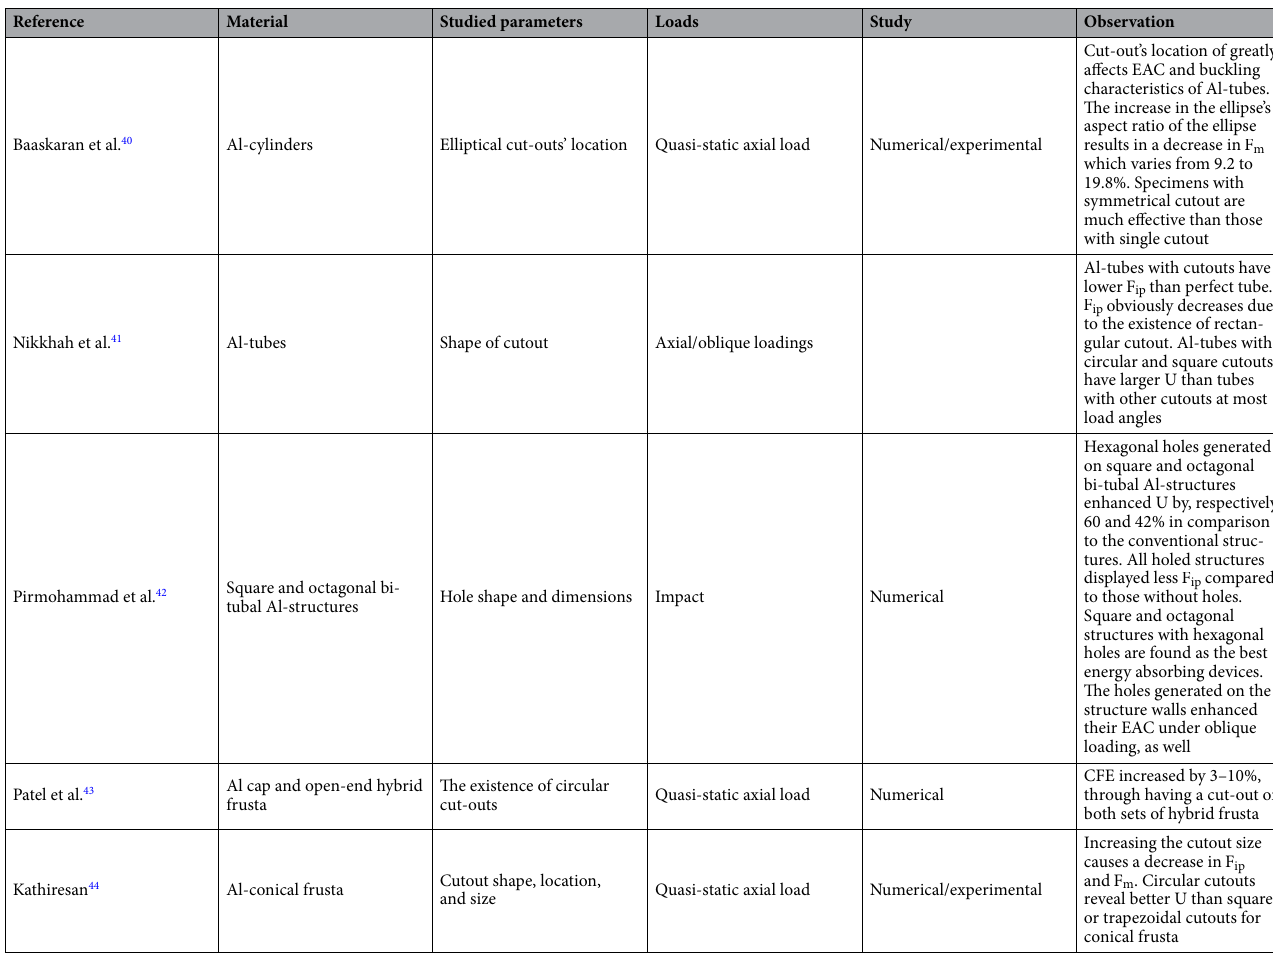
Table 1. Summary of research works on crashworthiness performance of metallic structures with cutouts.